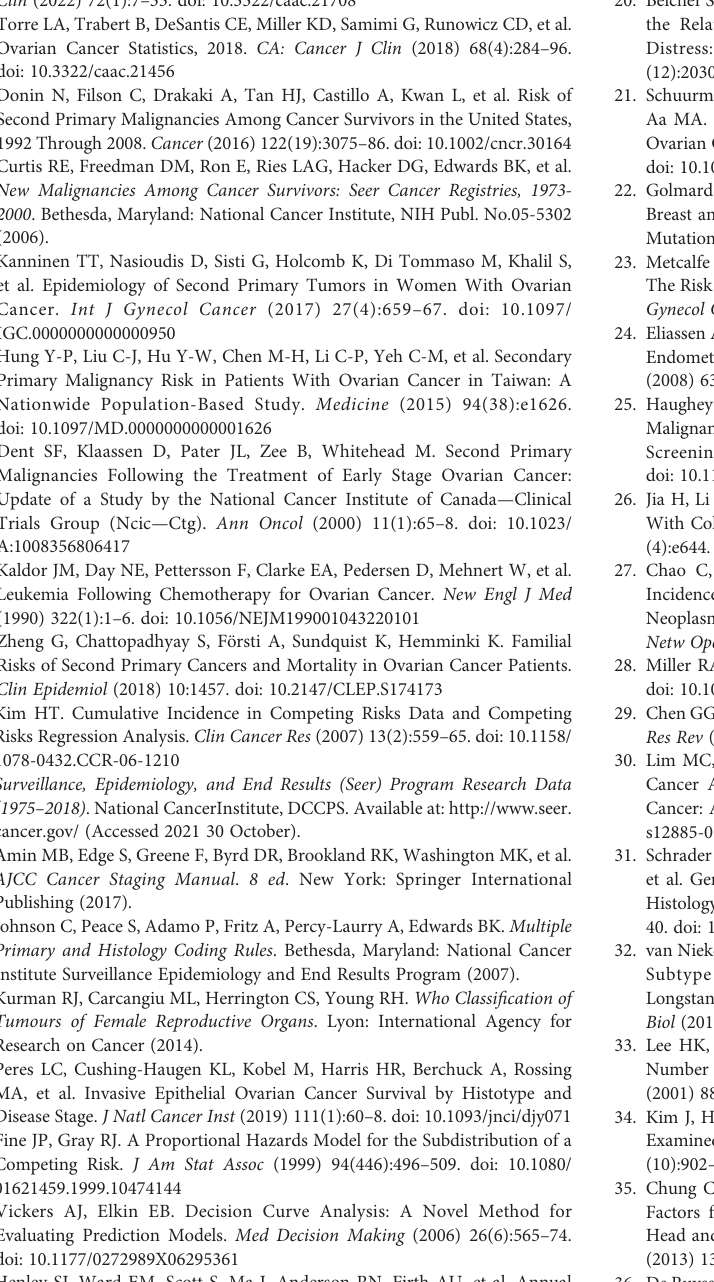
Supplementary Figure 3 | Calibrationcurvesfor5-yearpredictedvs.observed probabilityofdevelopingsecondprimarymalignanciesestimatedbytheFineandGraymodel. Supplementary Figure 4 | Calibration curves for 10-year predicted vs. observed probability of developing second primary malignancies estimated by the Fine and Gray